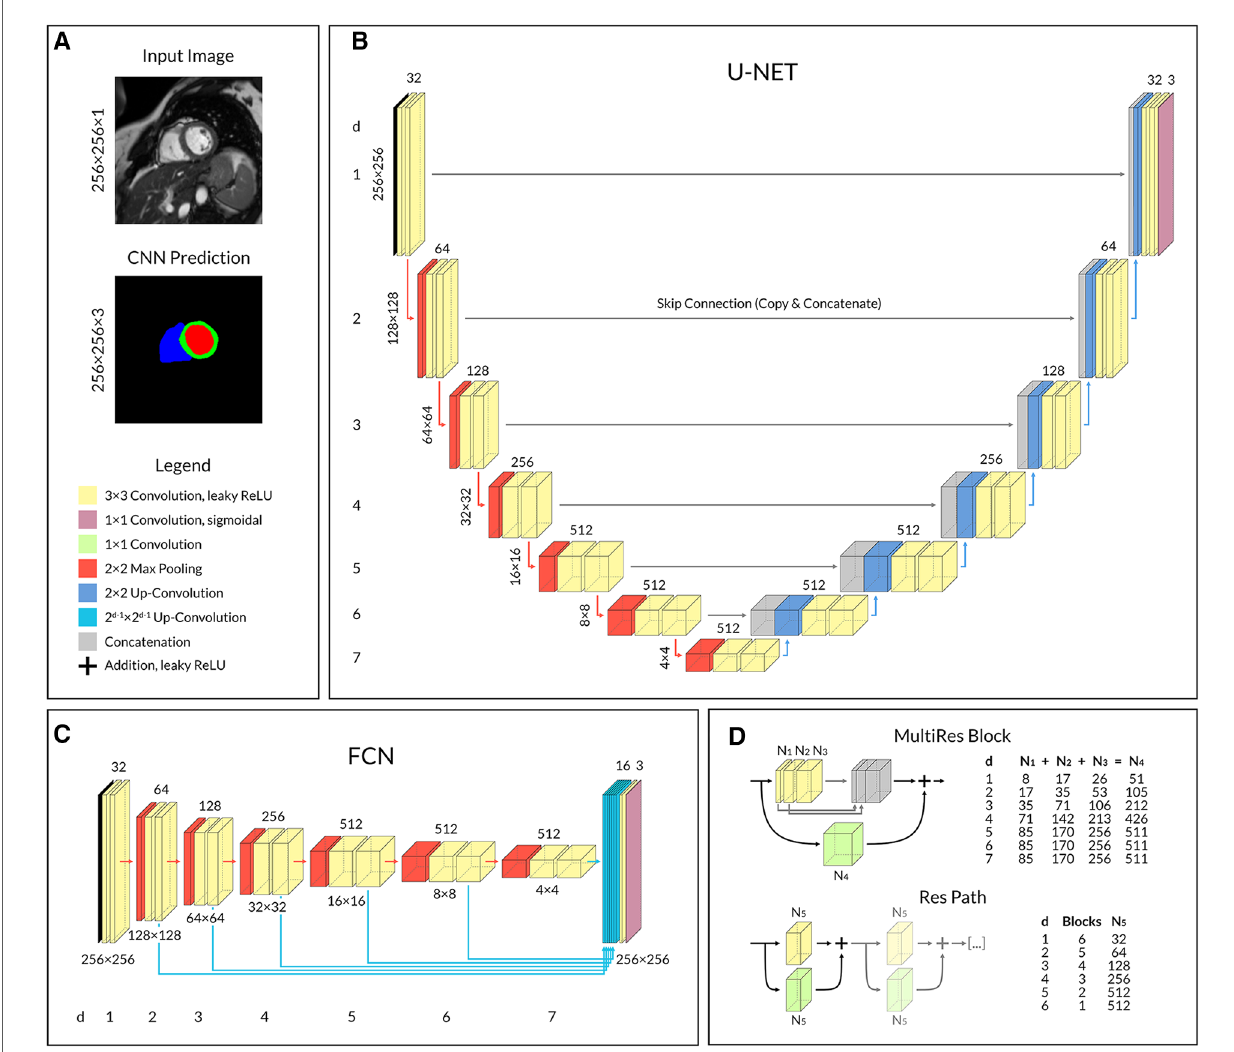
FIGURE 1 Convolutional neural network architectures. ( A ) Network input and output example with corresponding shape. Shared legend for operational blocks. ( B ) U-Net with symmetrical encoder and decoder architecture. ( C ) FCN with one-step decoding by 16-channel up-convolution and concatenation from each layer. ( D ) In MultiResUNet, a single MultiRes Block replaces the two convolutional operations in each layer of U-Net, and a Res Path replaces each skip connection. The number of feature channels varies with the depth of the layer in the CNN and is given in the two tables on the right. Legend: ReLU, recti fi er linear unit; d , layer depth; N 1 – 5 , Number of feature channels according to